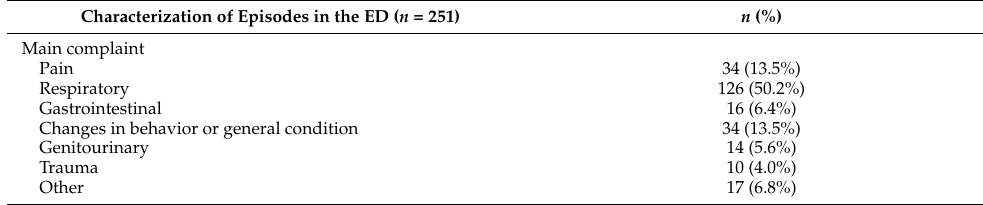
Table 5. Characterization of the patient sample and episodes in the emergency